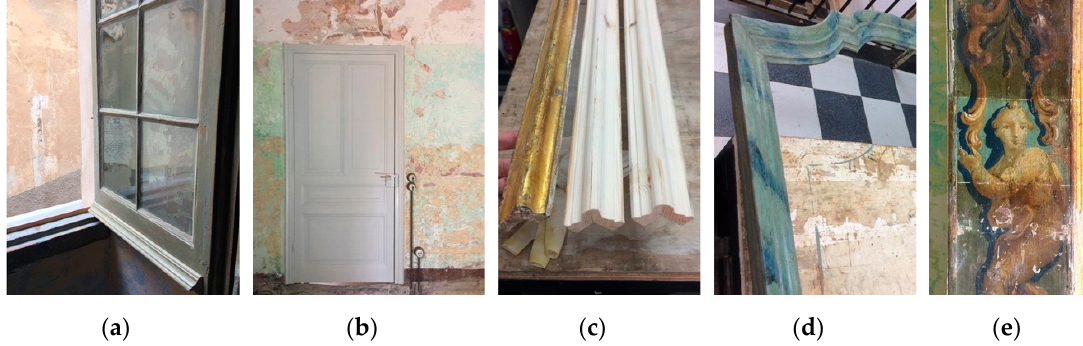
Figure 17. ( a ) Example of the restoration of the windows, ( b ) example of the restoration of the doors, ( c ) example of the restoration of the wooden window moldings, ( d ) example of the restoration of the wooden door moldings and ( e ) restoration of the wooden moldings of the alcove.